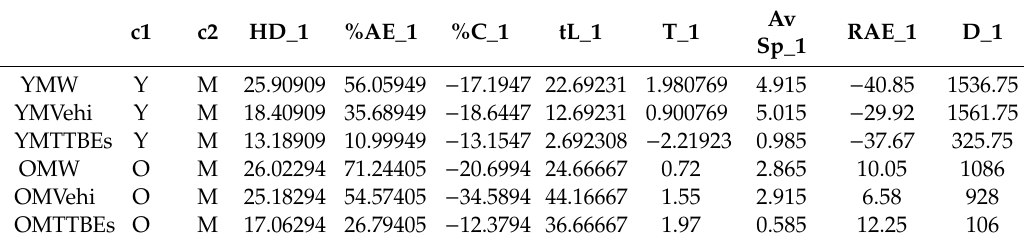
Table A1. Data matrix M 6,8 : male mice.